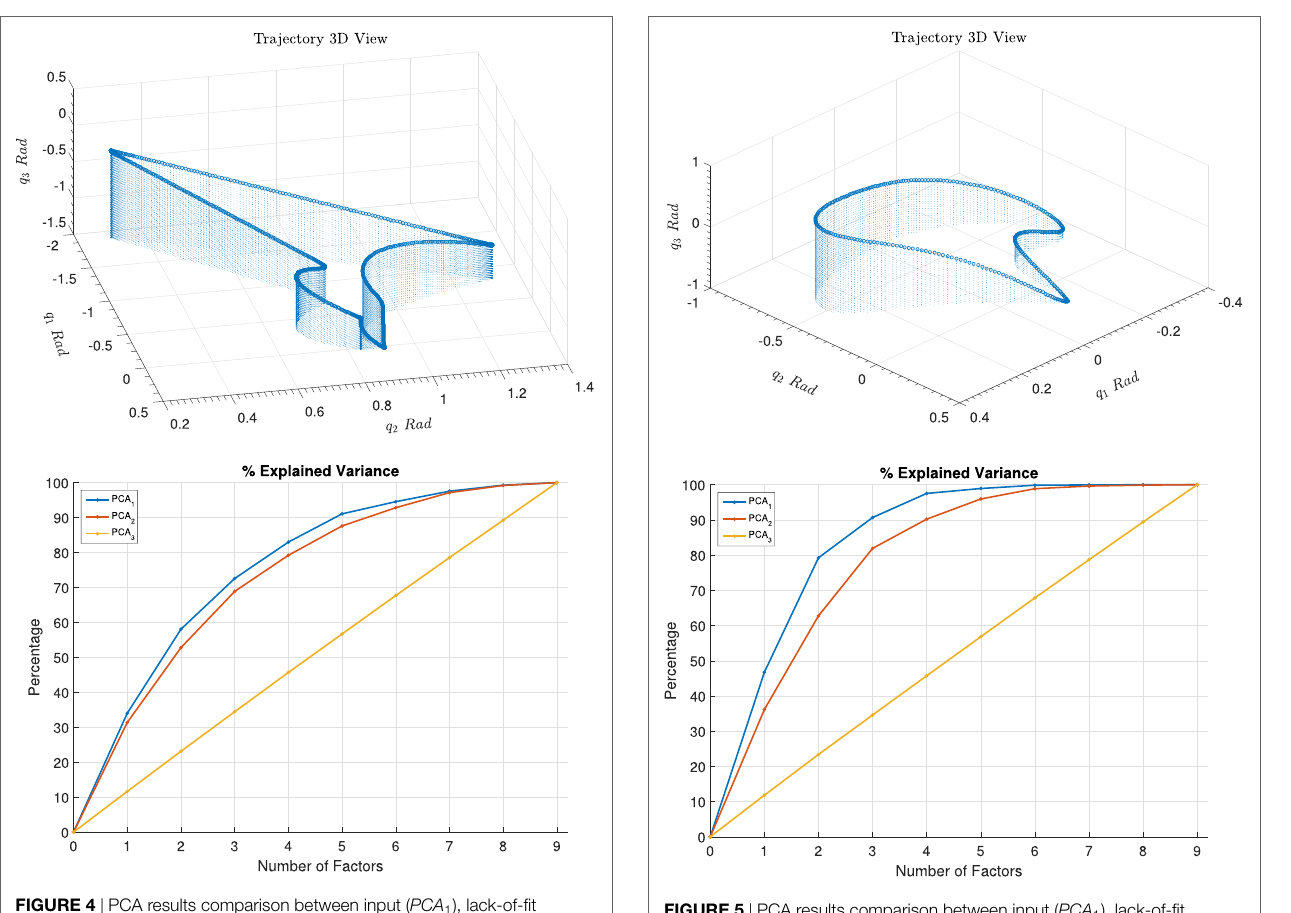
and their applications can be found in Wu et al. (1997a),